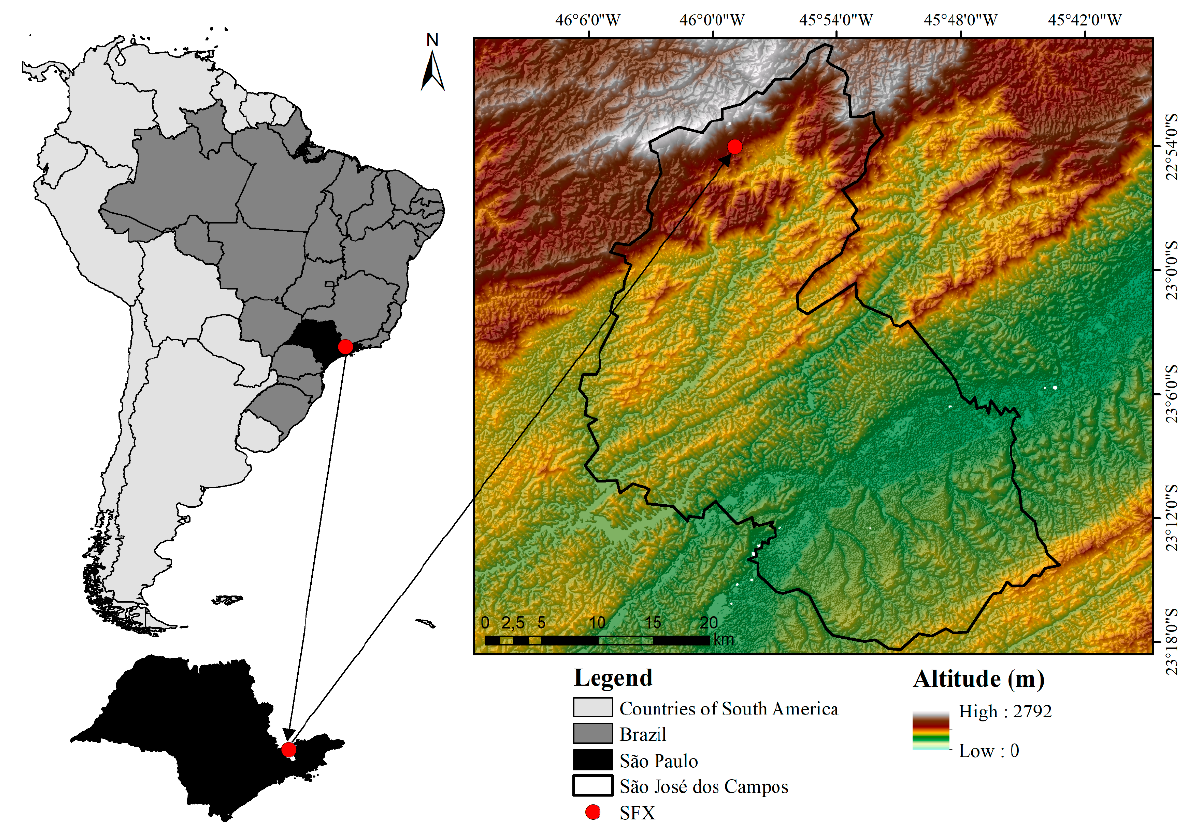
Figure 1. Map of S ã o Francisco Xavier geographical location and topography of the Figure 1. Map of São Francisco Xavier geographical location and topography of the region. According to the Köppen climate classification, the climate in the region is defined as Cwa, humid subtropical with dry winters and hot summers [24] , with the hottest month in February (average 23.9 °C) and the coldest month in July (average 16.4 °C) [25] . The annual rainfall is ~1885.0 mm (1950–2000, weather station code 02245050), when the rainy period occurs between October and March, presenting 78.3% (1475.9 mm) of precipitation during the